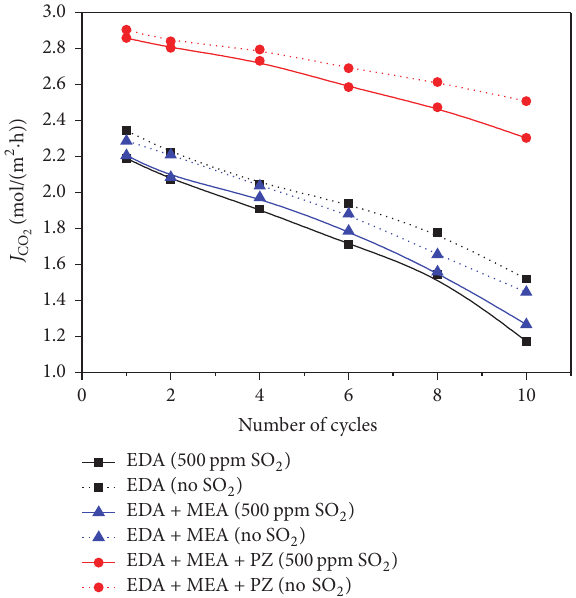
Figure 4: Influence of cycle absorption and desorption on the CO 2 removal efficiency ( 𝑈 𝑔 = 4m 3 /h, U